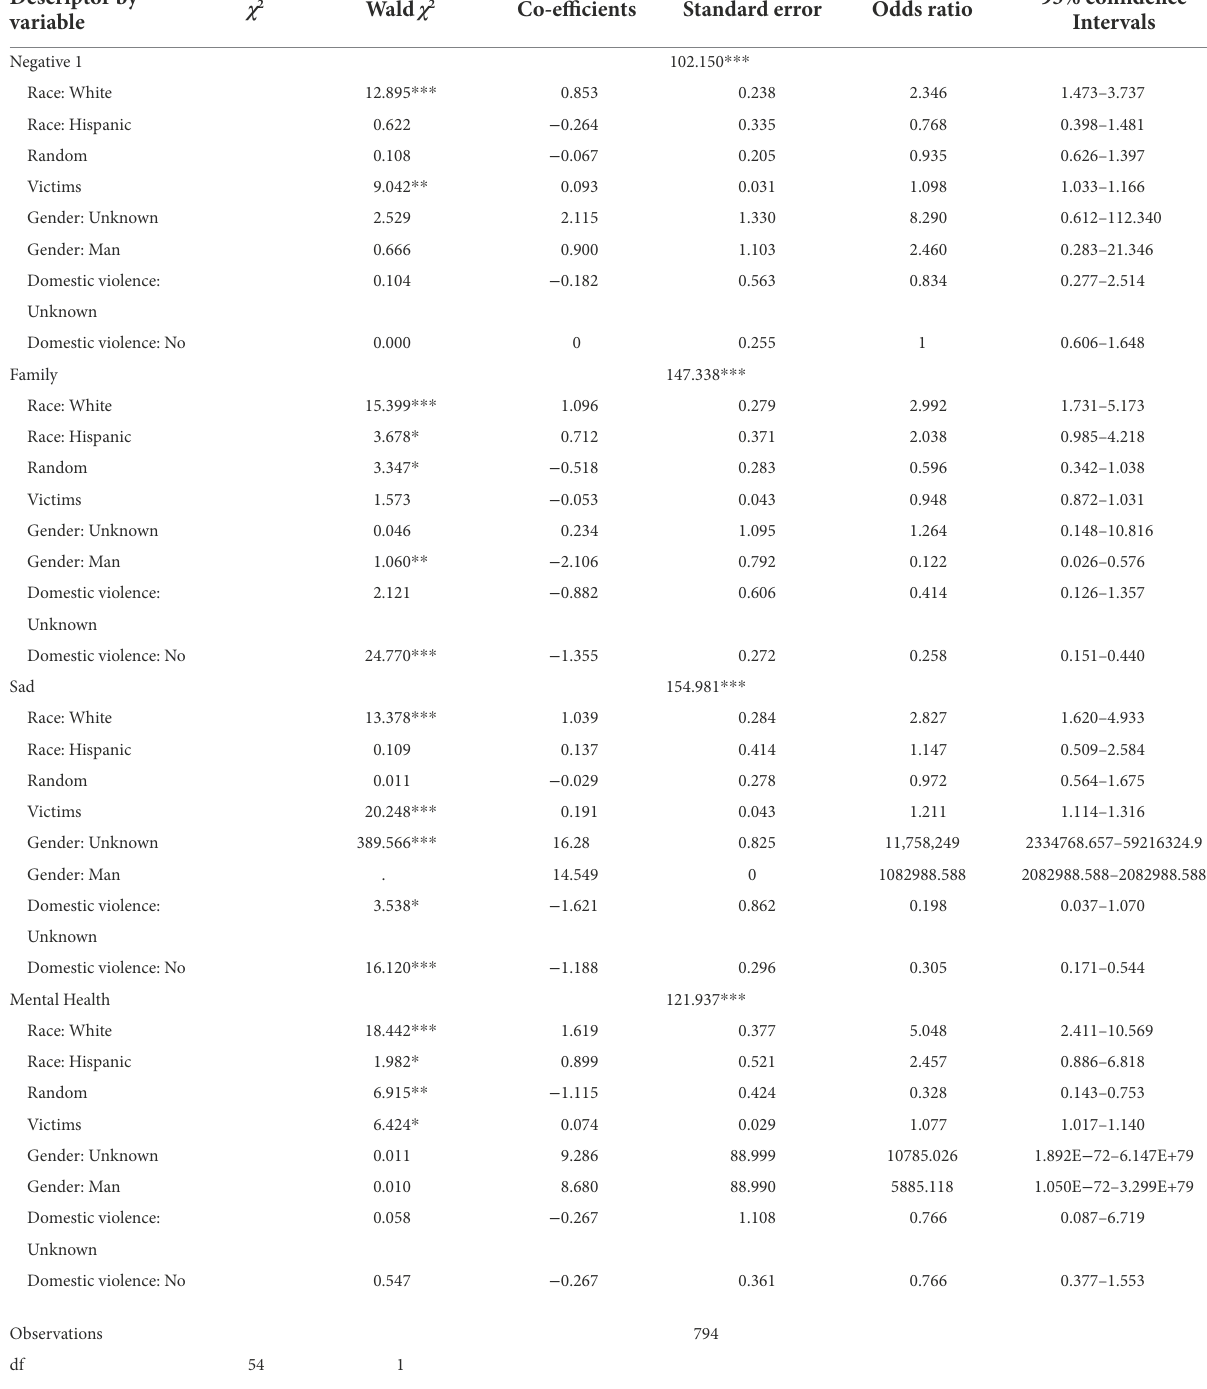
TABLE 9 Model 2: multinomial logistic regression analysis of descriptor type usage in media coverage of mass shooters by race with